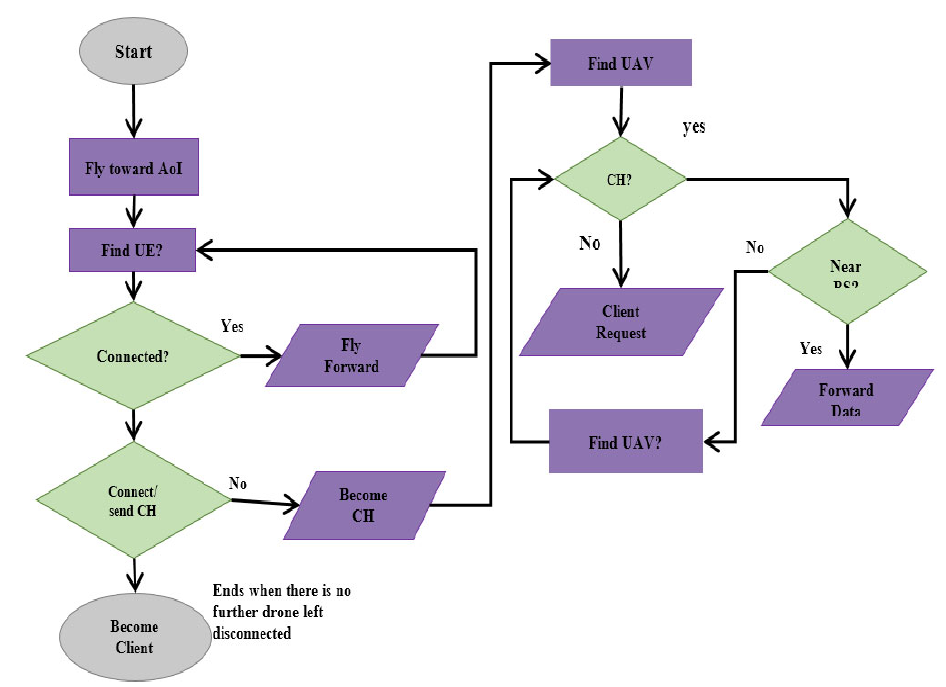
Figure 3. Creation of UAV CH and UAV client.